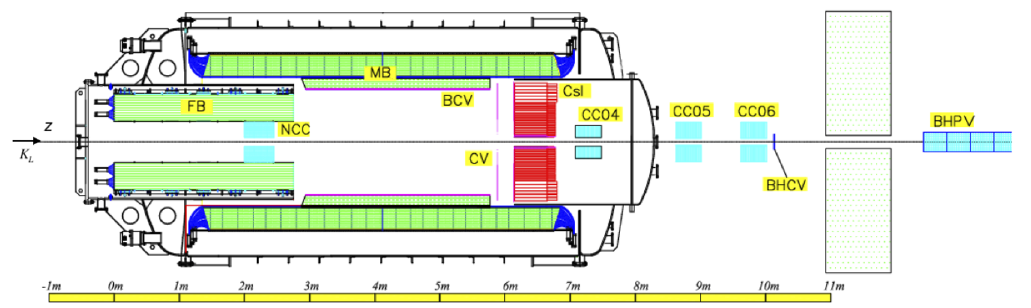
Figure 1 . Layout of the KOTO detector, taken from [66]. The Kaon beam enters from the left, as indicated by the arrow. Schematic drawing of the detector. The components of the detector include collar counters (CCxx), Neutron Collar Counter (NCC), Front Barrel (FB), Main Barrel (MB), charged-particle vetos (BCV and CV), CsI crystals (CSI), Beam Halo Charged Veto (BHCV) and Photon Veto (BHPV). For more information see